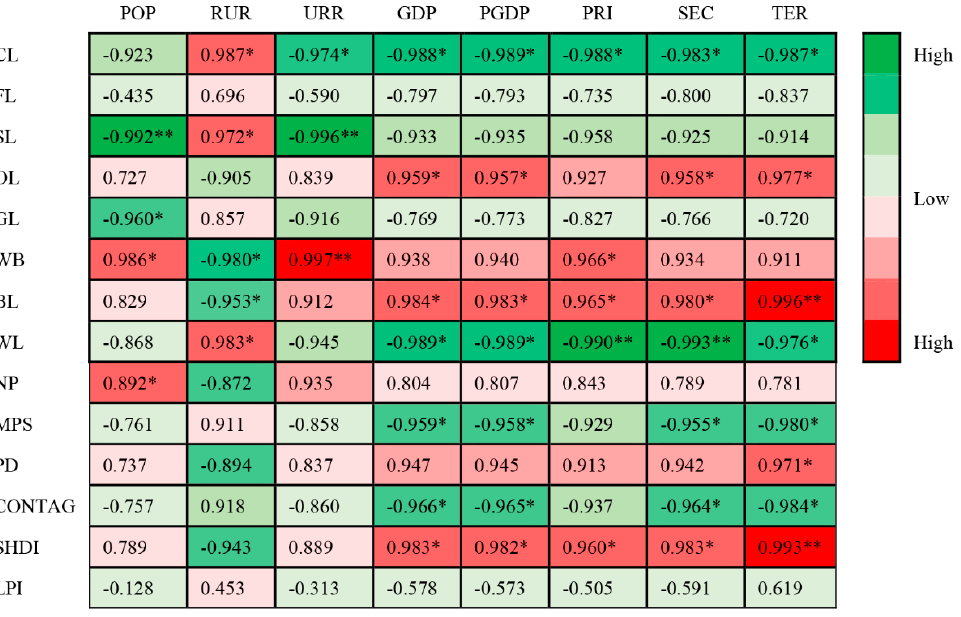
Figure 8. Socio-economic indicators in the middle reaches of the Yangtze River region from 1990 to 2015.